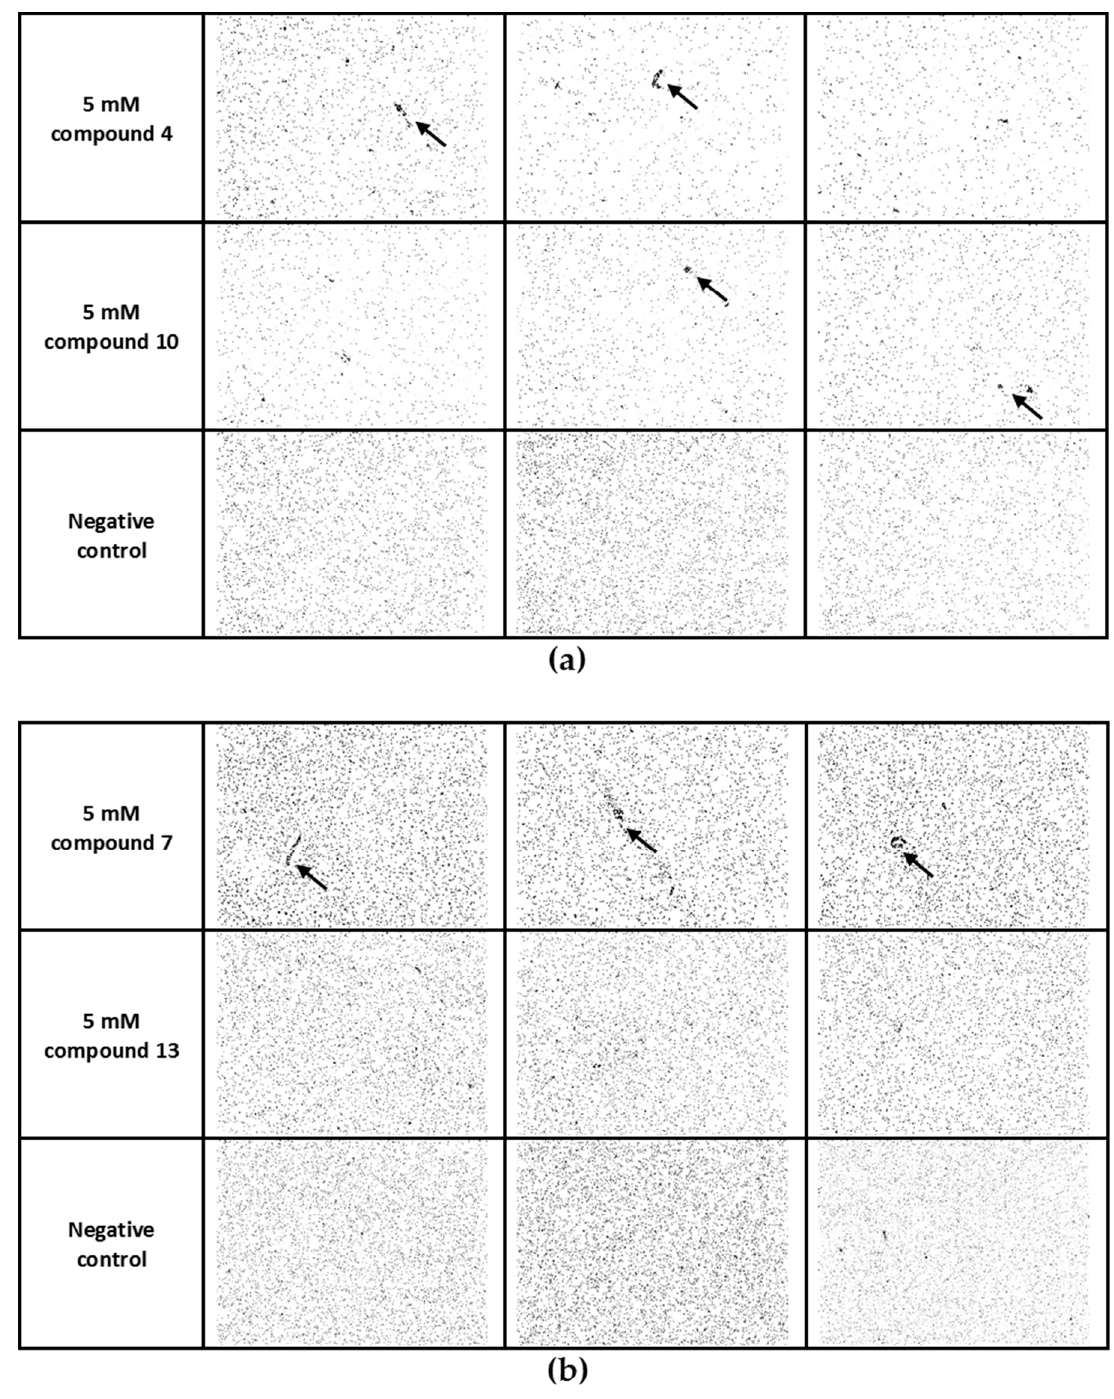
Figure 5. Cross-linking of Pseudomonas aeruginosa cells with d -galactopyranoside-presenting inhibitors. The P. aeruginosa cells with no added inhibitors were used as a control. Magnification 100x, phase contrast, background subtraction in GIMP, triplicates. The results for the highest concentrations used are presented. For the other concentrations used, see Figures S2 and S3 in the Supplementary data. The representative aggregates are highlighted by the black arrows. ( a ) Results for compounds 4 and 10 ; ( b ) Results for compounds 7 and 13 .